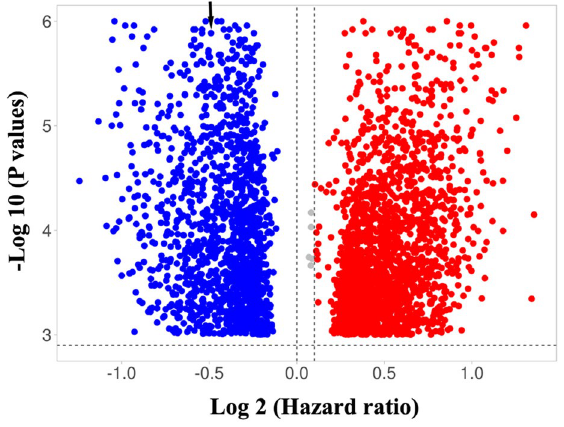
Figure 1. Volcano plot for GSE10846 indicating RTN1 position (arrow) as the most reproducible prognostic gene. Similar plots for other datasets were provided in the Supplementary Figures.